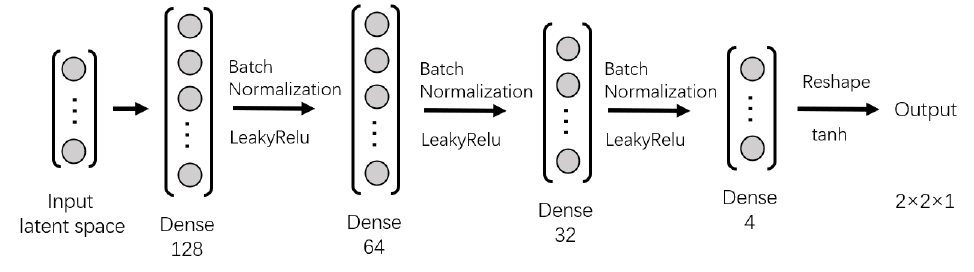
Figure 13. The eye dataset which contains two eyes. One eye is rotated and reflected to produce a second eye.